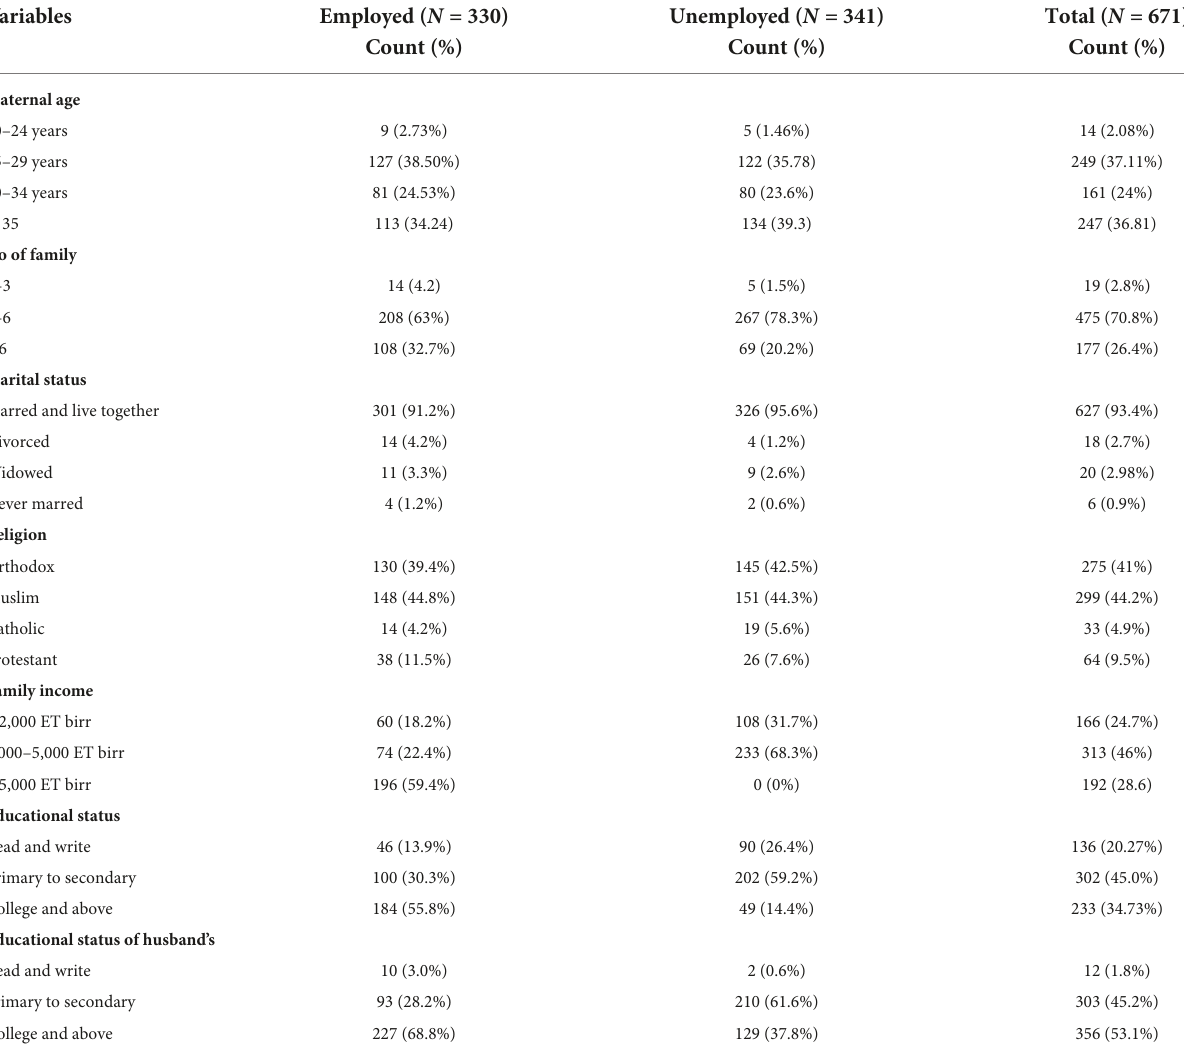
TABLE 1 Socio-demographic characteristics of mothers who have 6–59 months old children, in Gurage Zone SNNPR Ethiopia, 2021 ( n =